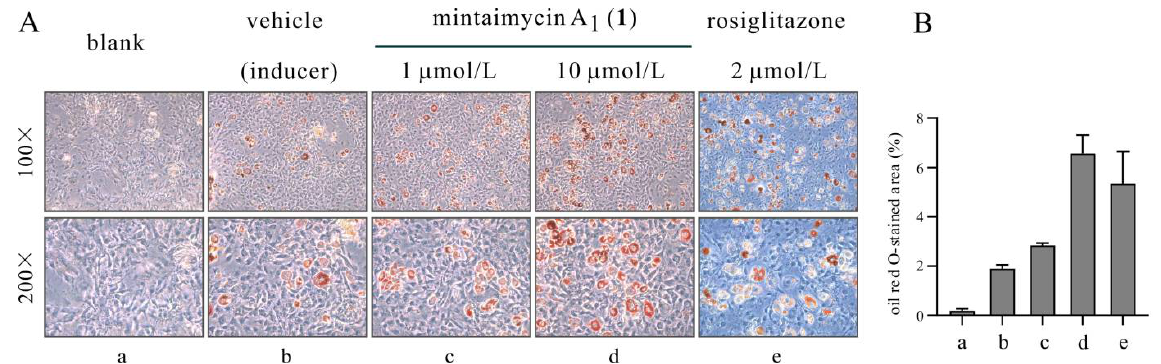
Figure 5. Mintaimycin A 1 ( 1 ) induced differentiation of 3T3-L1 fibroblast cells to adipocytes. Com- pared to vehicle-treated 3T3-L1 fibroblast cells, cells treated with mintaimycin A 1 ( 1 ) at 10.0 μmol/L produced prominent oil red O-stained lipid droplets after an incubation period of 14 days, suggest- ing that it promoted 3T3-L1 fibroblast cells to differentiate into lipid-accumulating adipocytes. Rosiglitazone (an anti-diabetic drug) at 2.0 μmol/L was used as positive control in the assay. A mix- ture of 10.0 μg/mL of insulin, 0.5 mmol/L of 3-isobutyl-1-methylxanthine and 1.0 μmol/L of dexa- methasone was used as an inducer for cell adipogenesis. ( A ) Representative images of oil red O staining of 3T3-L1 cells at day 14, a: blank; b: vehicle (inducer); c: 1.0 μmol/L ( 1 ); d: 10.0 μmol/L ( 1 ); e: 2.0 μmol/L (rosiglitazone); ( B ) differentiation-inducing activity quantified by oil red O-stained images (100× magnification).